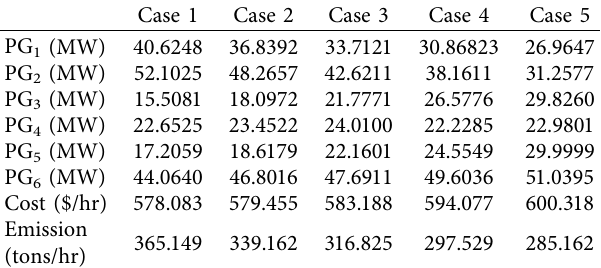
Table 10: Optimized variables for strategy B